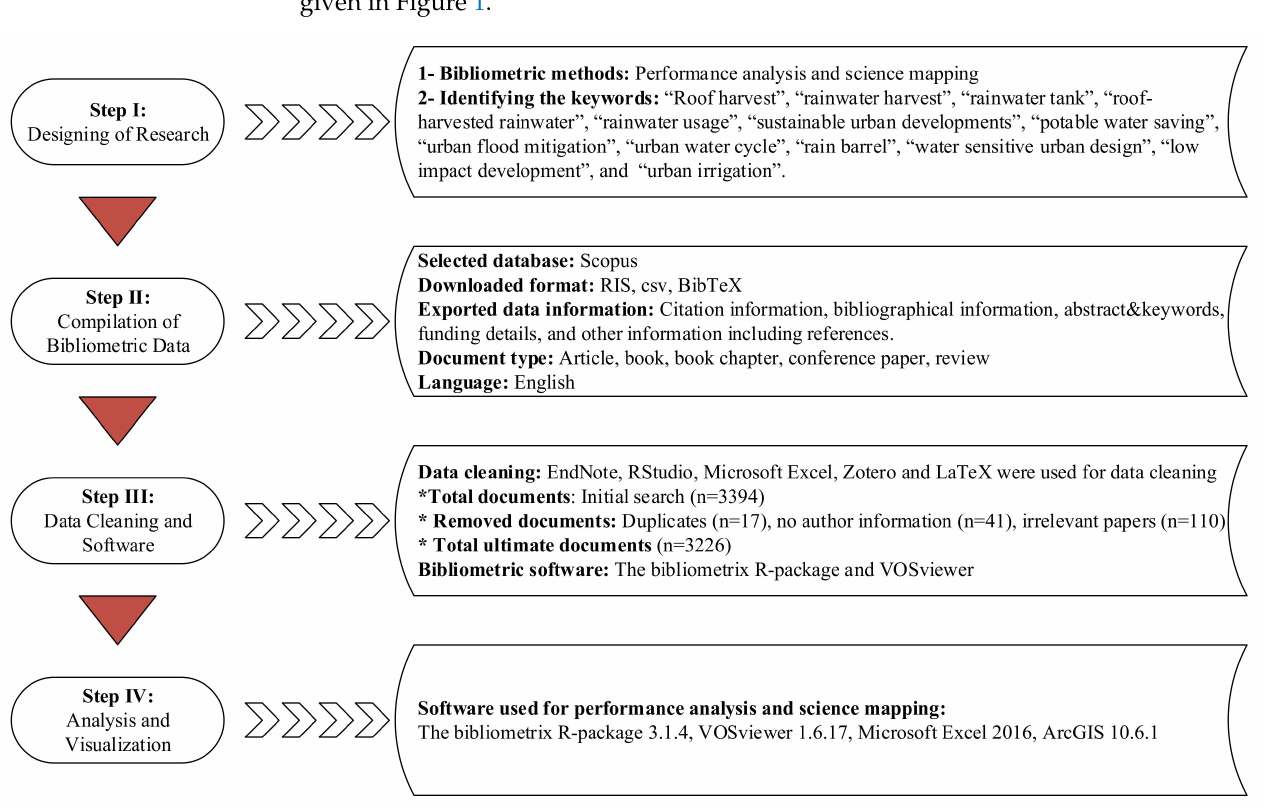
Figure 1. Adopted workflow for conducting bibliometric analysis carried out in this